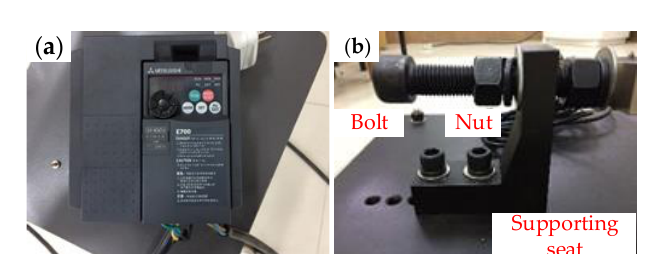
Figure 5. Bearing test rig.